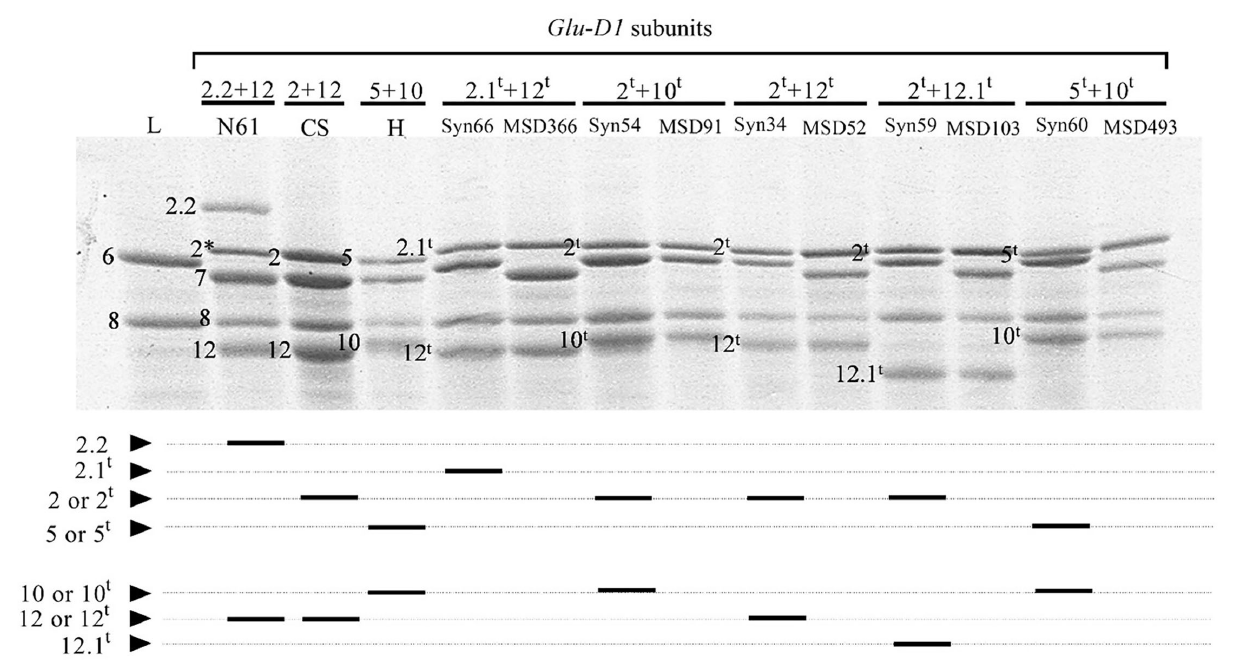
subunit pair 2 t + 12 t , although it is the most abundant subunit in MSD lines ( Table 2